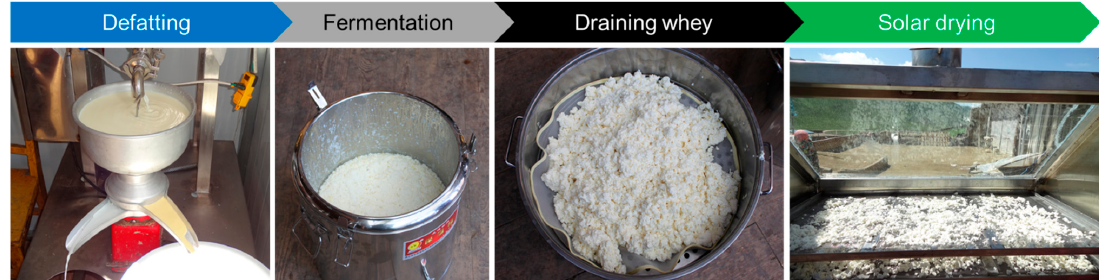
Figure 1. Material’s Preparation Scheme.